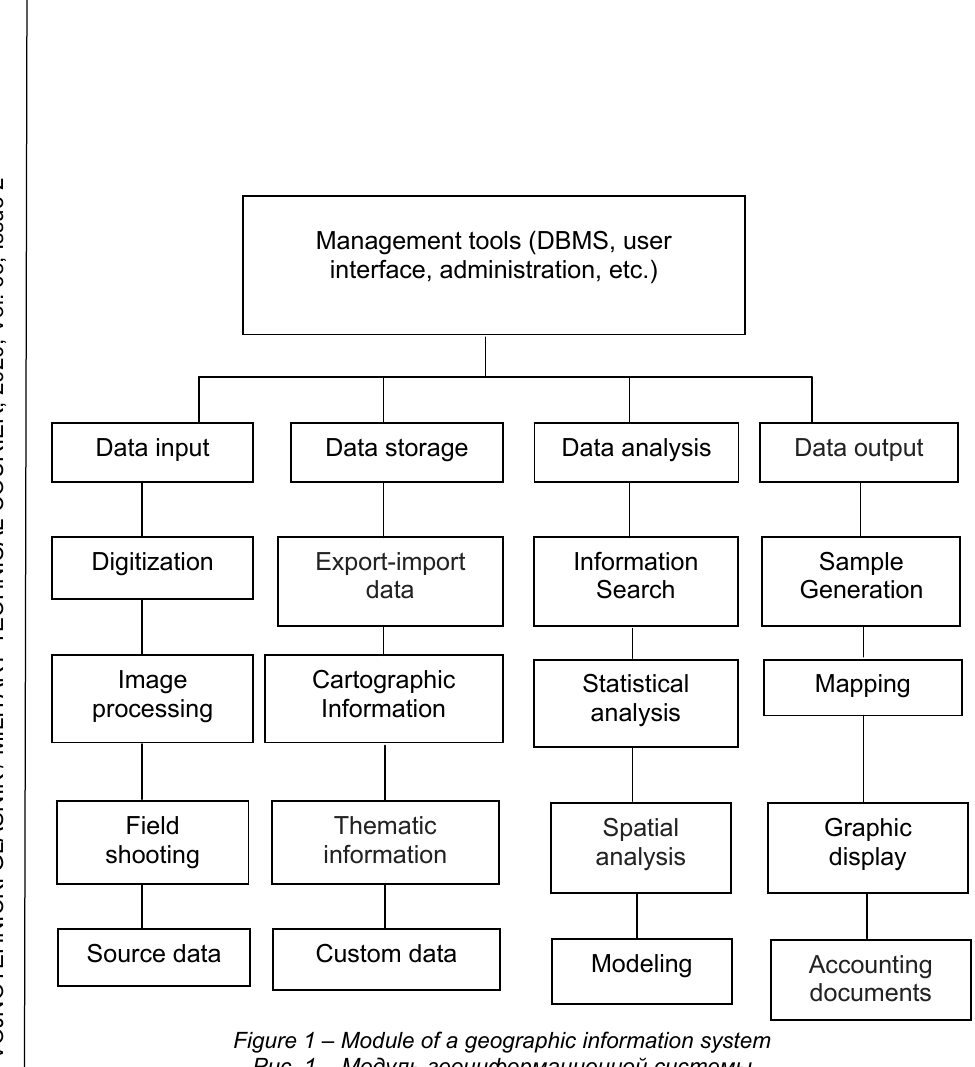
Figure 1 – Module of a geographic information system Рис . 1 – Модуль геоинформационной системы Слика 1 – Модел географског информационог